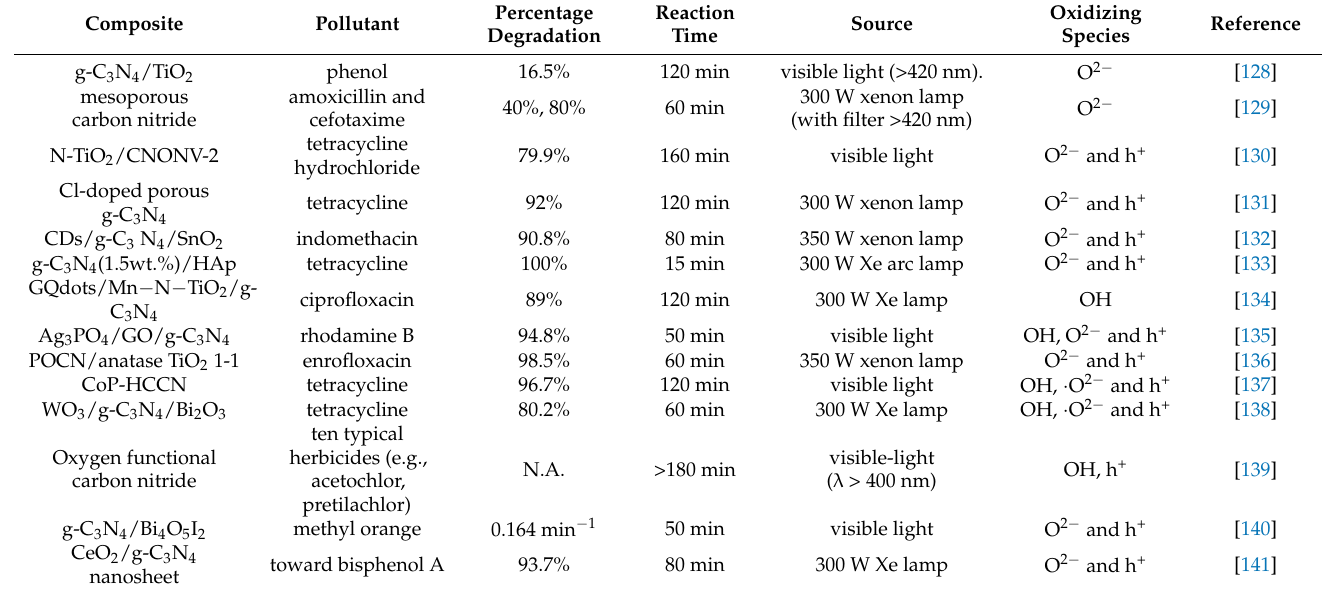
Table 2. g-C 3 N 4 composites and their photocatalytic degradation of organic pollutants.